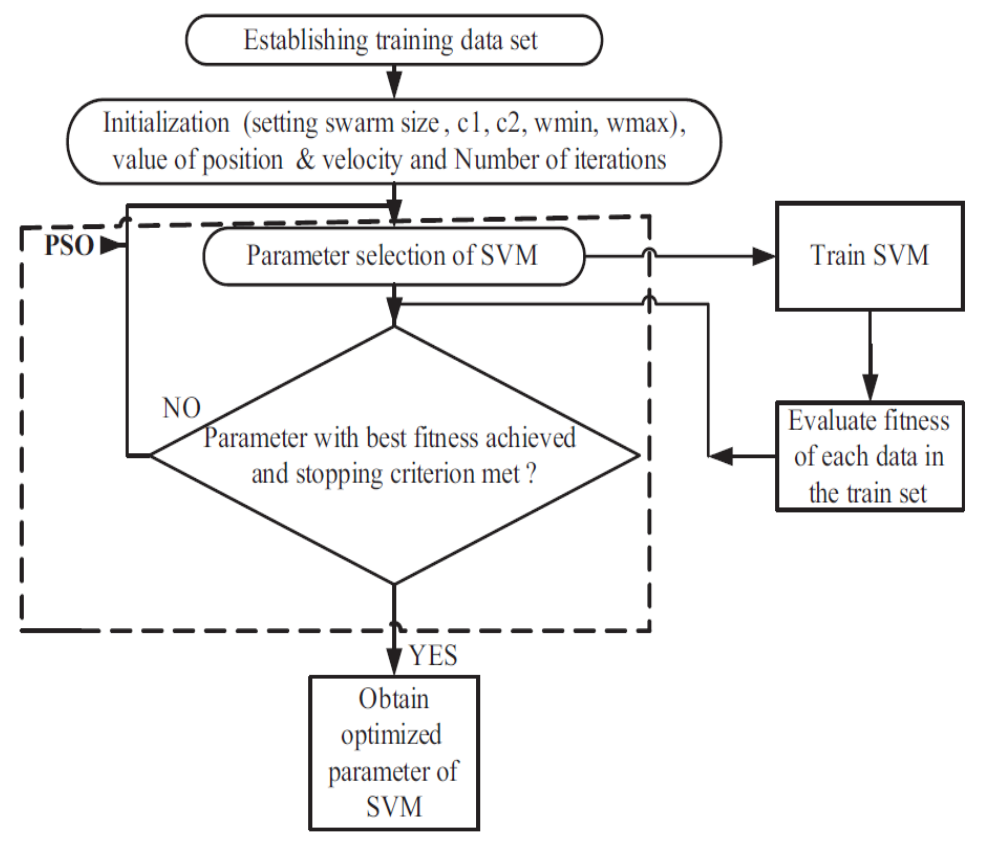
Figure 3. PSO parameter selection design.